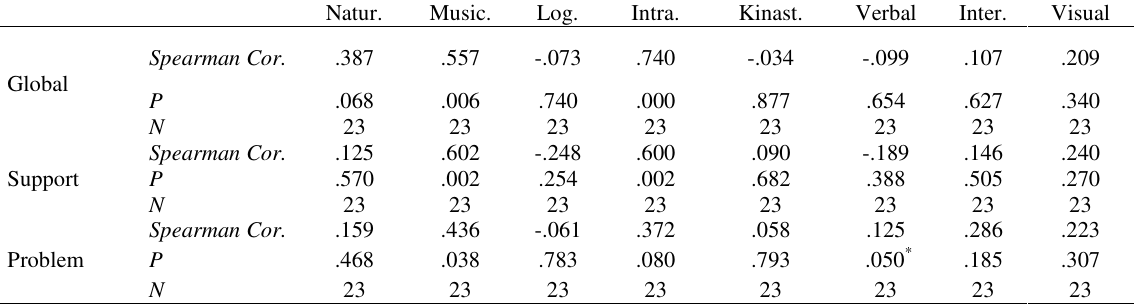
Table 5 Spearman Correlation for Successful EFL Readers’ Reading Strategies &